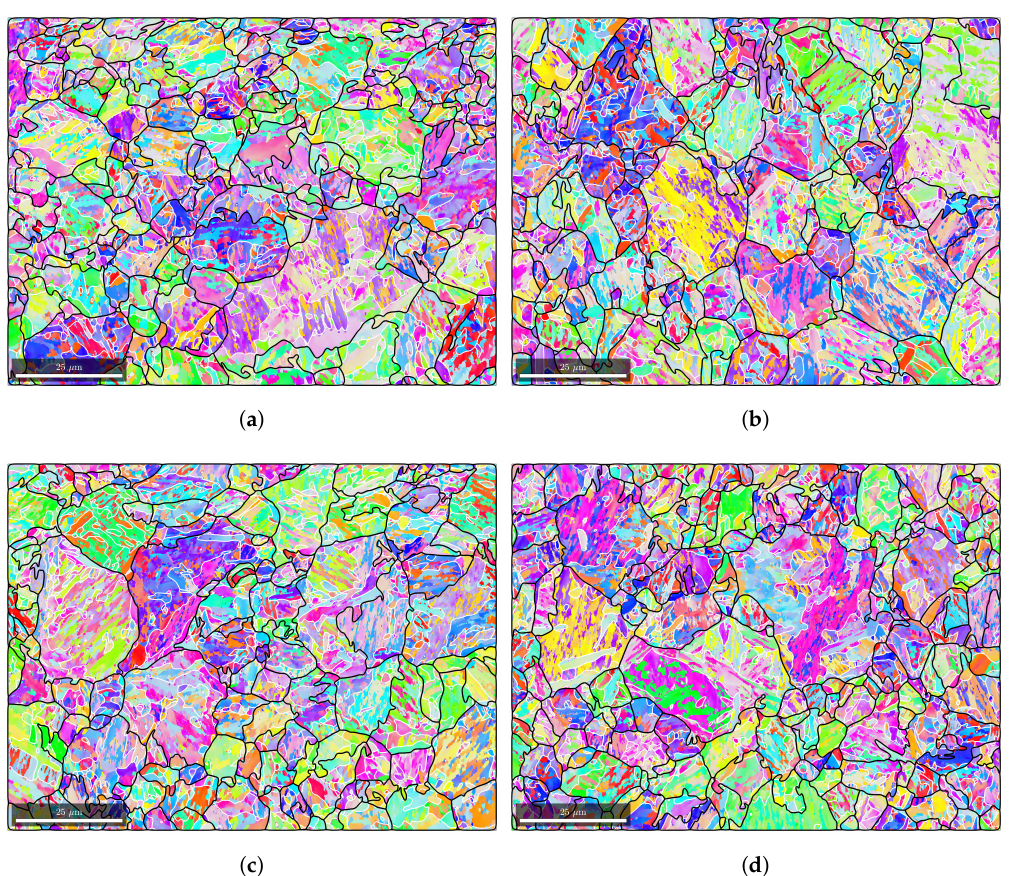
Figure A1. EBSD map in an inverse pole figure color scheme with superimposed prior austenite grain boundaries, recrystallization twin boundaries (black) and close packet plane packets (white). ( a )